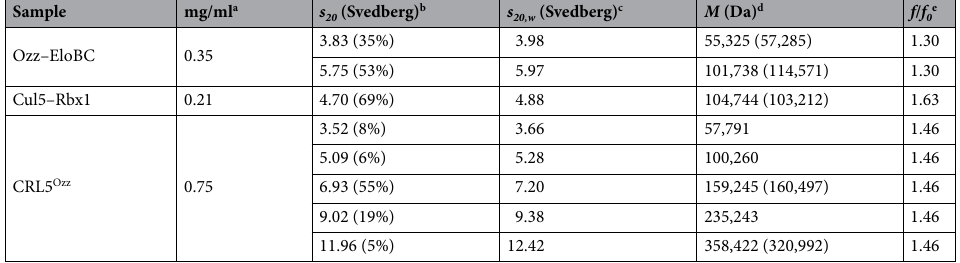
Table 2. Summary of results of the velocity c ( s ) analysis of Ozz–EloBC, Cul5–Rbx1 and CRL5 Ozz (Ozz– EloBC + Cul5–Rbx1) complex in 10 mM sodium phosphate, 1.8 mM potassium phosphate pH 7.2, 137 mM NaCl and 0.27 mM KCl buffer at 20 °C. a Total concentration of sample in mg/ml. b Sedimentation